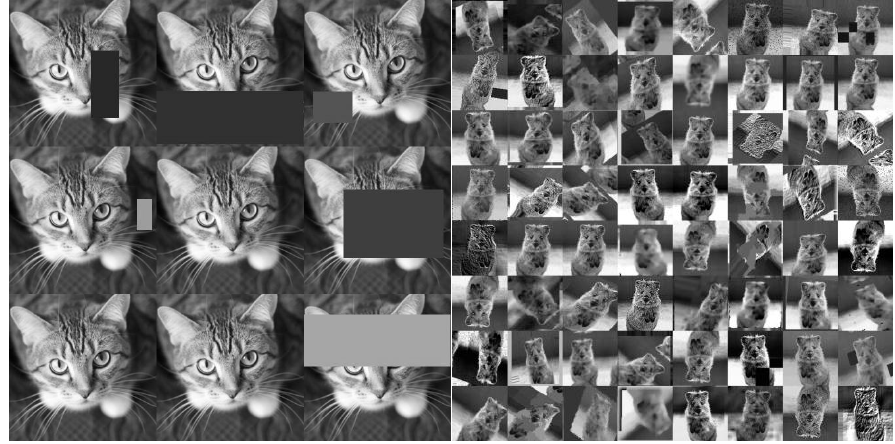
Figure 2. (Left) An example of applying the Cutout augmentation to an image. Source: github.com/xkumiyu/numpy-data-augmentation. (Right) A sample of possible data augmentation schemes. Source: